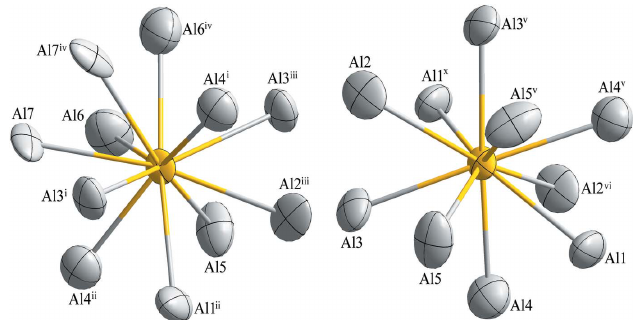
Figure 2 Details of the coordination polyhedra around Cr1 (left) and Cr2 (right). Displacement ellipsoids are given at the 99.8% probability level. [Symmetry codes: (i) 1 + x , y , 1 + z ; (ii) x , y , 1 + z ; (iii) 1 + x , y , z ; (iv) 1 (cid:3) y , z ; (v) x , 1 (cid:3) y , z ; (vi) x , y , (cid:3) 1 + z ; ( x ) (cid:3) 1 + x , y , z .] + x , 1 2 2